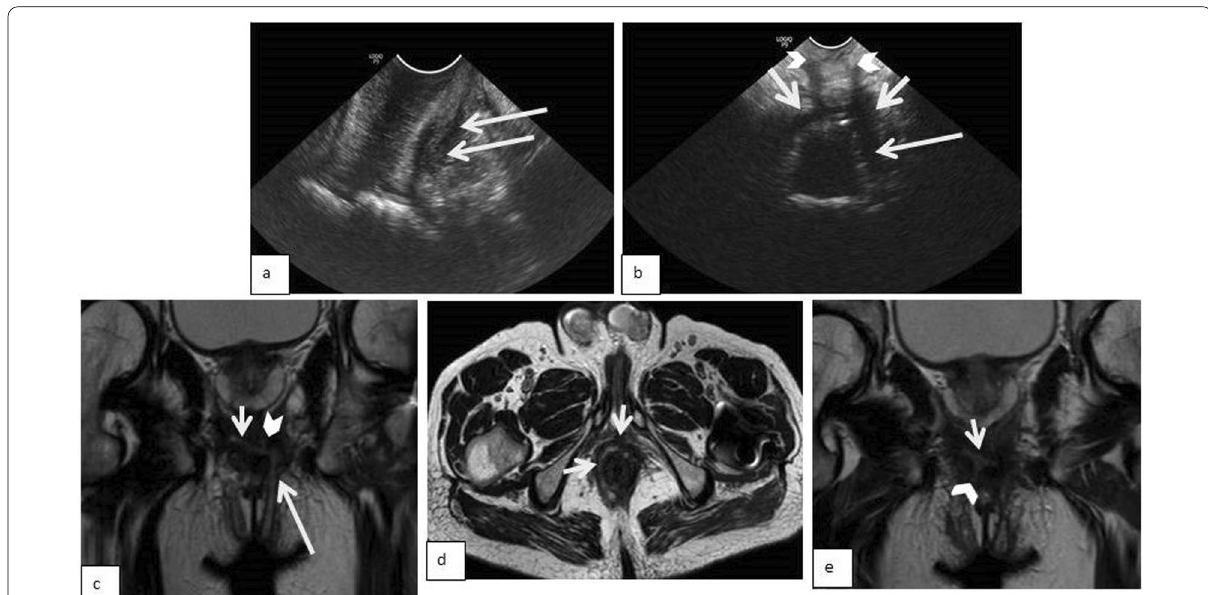
Fig. 6 a 60 years old male, with history of recurrent perianal fistula, presented with perianal pain and discharge. TPUS in oblique coronal plane ( a ) shows a left‑sided perianal tract (long arrow), in oblique axial ultrasound image ( b ), such tract forms an anterior horseshoe collection (short arrows) from which two small side branches are noted emerge (arrowheads). In T2 coronal oblique MR image( c , e ) and T2 oblique axial T2 image ( d ), the left‑sided trans‑sphincteric tract is seen (long arrow) forming an anterior horseshoe collection (short arrows) with two small side branches are noted (arrowheads in c , e